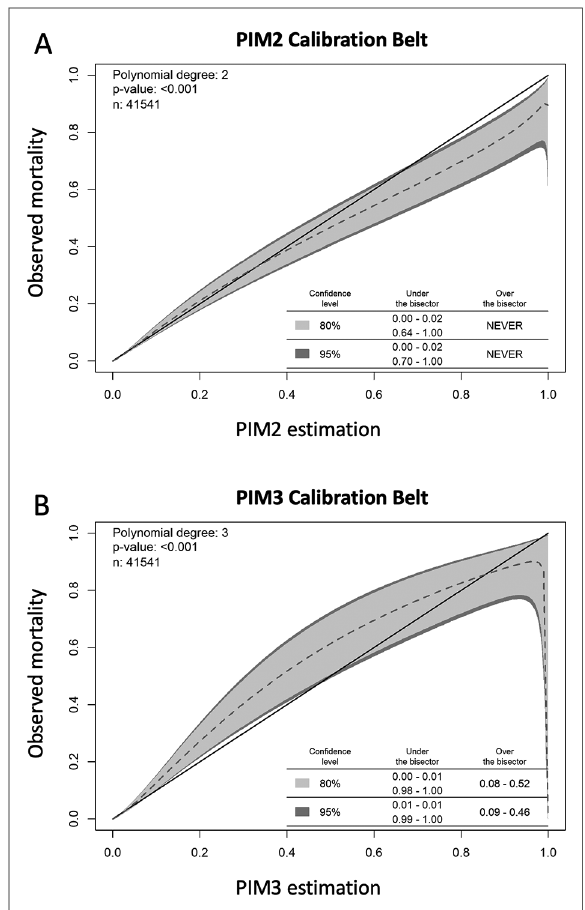
FIGURE 3 Calibration belts for PIM2 ( A ) and PIM3 ( B ), assessing the concordance of observed vs. expected outcome in 10 deciles of patient risk. The dashed line represents the mean line compared to the bisector, which indicates a perfect match between the PIM results and the outcomes it tries to predict. The p -value expresses a Wald-like statistic that tests the null hypothesis that there is no difference between this line and the bisector, which was rejected for PIM2 and PIM3. The inner light gray area marks the 80% CI boundary, and the dark gray outer belt marks the 95% CI boundary. For PIM2, the calibration belt is never over the bisector and is under the bisector (overestimating mortality) in a very low risk range below 2% mortality risk and over 70% predicted mortality, indicating that PIM2 overestimated the mortality for these high-risk patients. For PIM3, the calibration belt is over the bisector between 0.09 and 0.46 predicted mortality, underestimating the mortality in this risk range, and it is under the bisector (overestimating mortality) in a small range in less than 1% and above 99% mortality